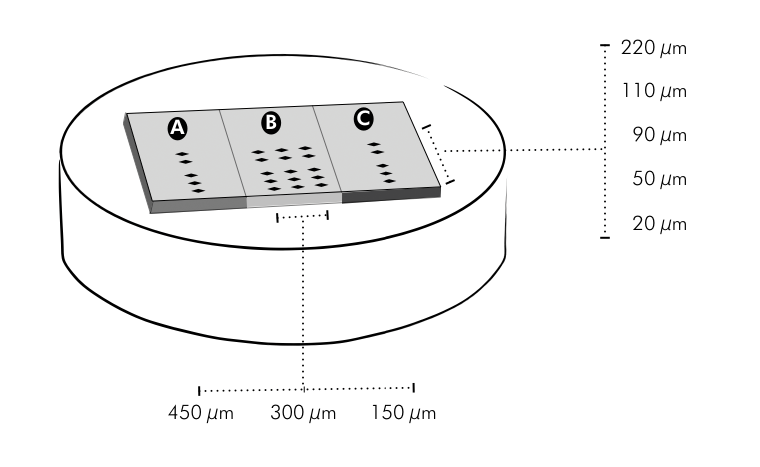
Figure 2. Distances of indentations and depth from the margin of each measured area for both SH and CSH